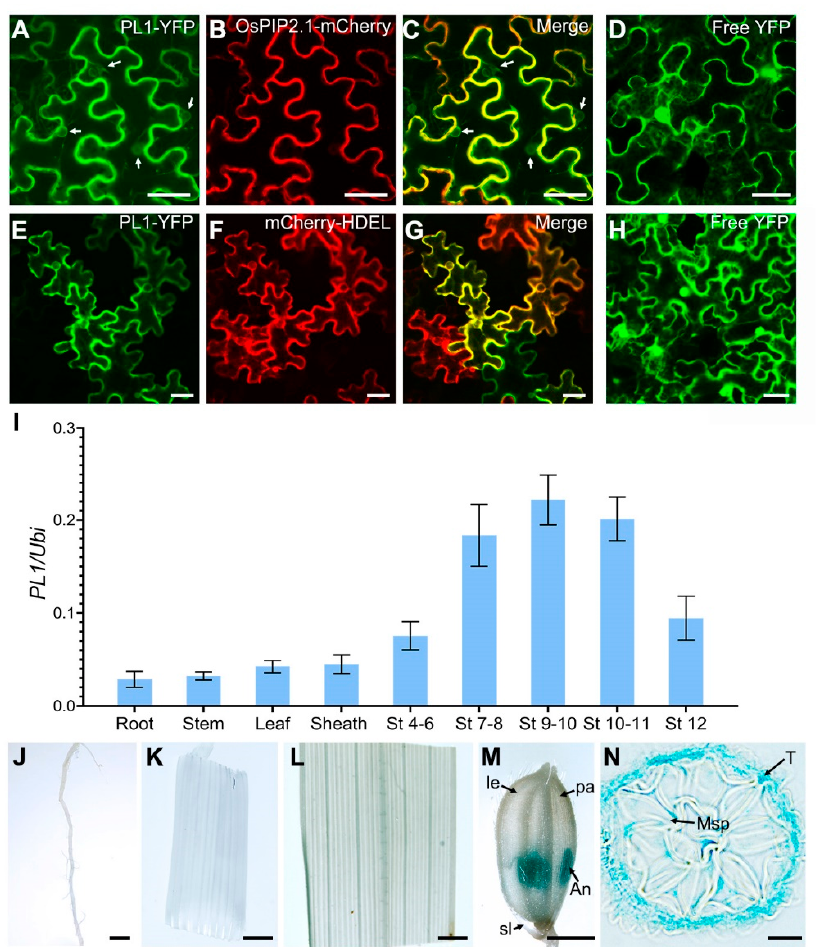
Figure 5. Expression analysis of PL1 . ( A–H ) Subcellular localization analysis of PL1-YFP fusion protein in tobacco leaves. The co-expression of PL1-YFP and PM marker (OsPIP2.1-mCherry) is shown in ( A–D ). The co-expression of PL1-YFP and ER marker (mCherry-HDEL) is shown in ( E–G ). The free YFP that is used as a control is shown in ( D ) and ( G ). The arrows in ( A ) and ( C ) indicate the ER-like structures. ( I ) Expression pattern of PL1 . The expression levels were examined by qRT-PCR. RNA was extracted from root, stem, leaf, sheath and spikelets with anthers at di ff erent developmental stages (St). Data are shown as means ± SD (n = 3). ( J–M ) GUS staining of the PL1pro::GUS transgenic plant. GUS activity in root ( J ), stem ( K ), leaf ( L ), spikelet with anthers at stage 10 ( M ). ( N ) Cross-section of anthers from ( M ). Bars = 10 µm in ( A–H ), 2 mm in ( J–M ) and 25 µm in ( N ).